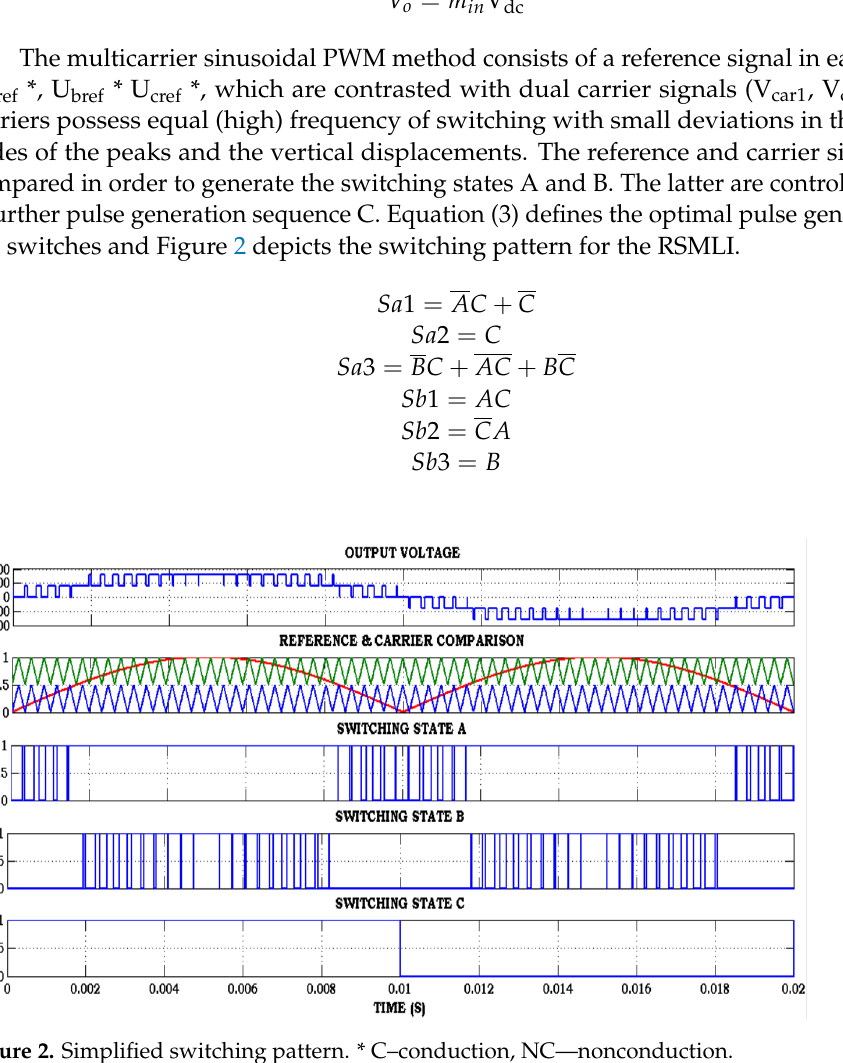
Figure 2. Simplified switching pattern. * C–conduction,